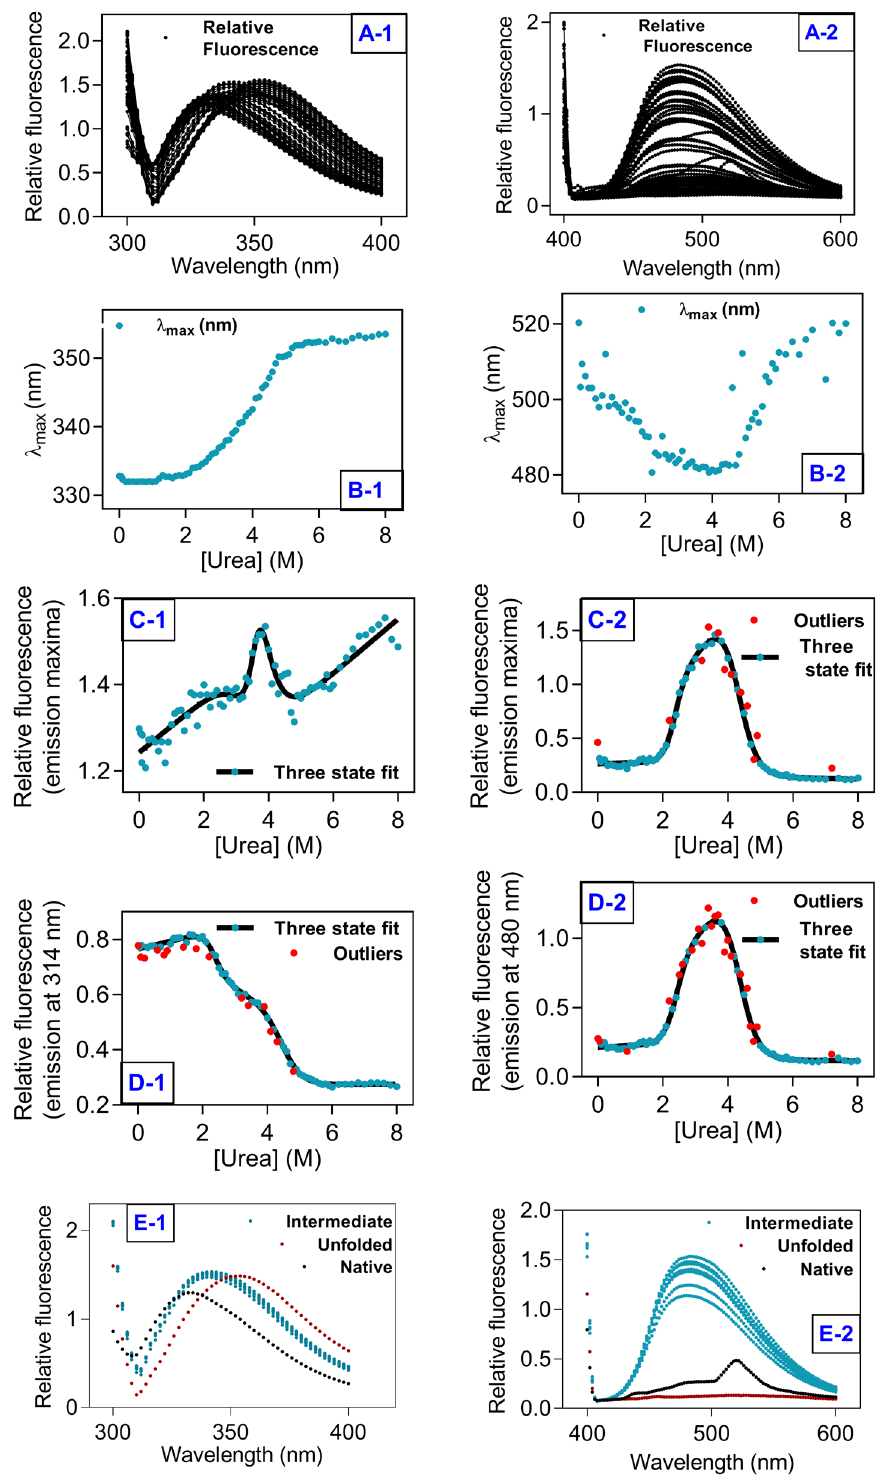
Figure 2. Urea induced unfolding studies of human aldose reductase (hAR)monitored by fluorescence. ( A1 ) Trp fluorescence scans and ( A2 ) ANS fluorescence scans for all the samples. ( B1 ) λ (Trp fluorescence) and ( B2 ) λ (ANS fluorescence) against [urea]. ( C1 ) max max I (Trp fluorescence) and ( C2 ) I (ANS fluorescence) against [urea]. ( D1 ) I (Trp fluorescence) and ( D2 ) I (ANS fluorescence) max max 295/314 370/480 against [urea]. ( E1 ) Trp fluorescence and ( E2 ) ANS fluorescence of samples in native (black), intermediate (cyan), and unfolded state (red). Solid lines represent curves fitted to the unfolding transitions; filled symbols represent data points from unfolding experiments; red symbols represent outliers. Page 7